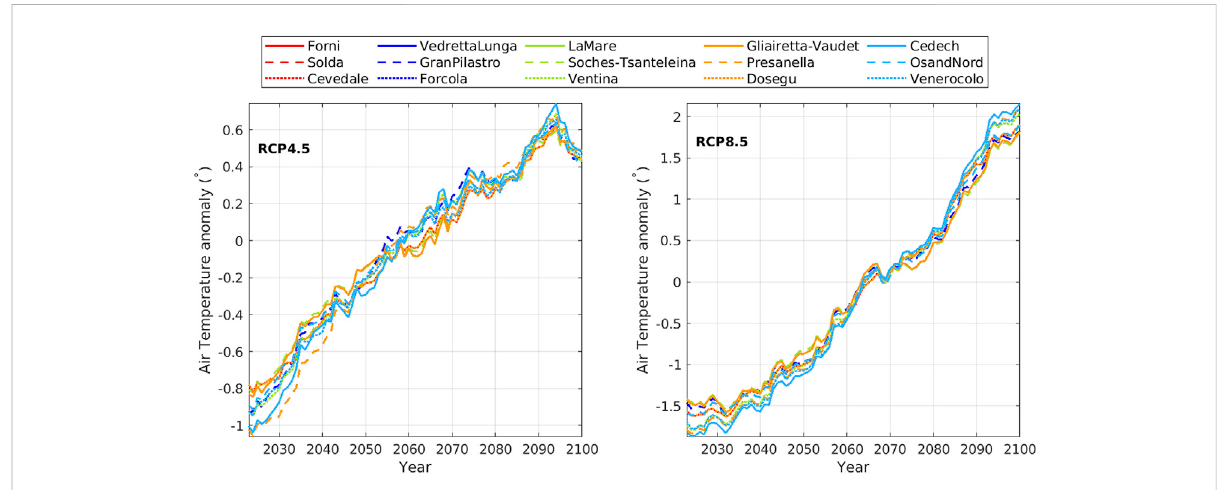
FIGURE 4 The ensemble air temperatures variations over the six regional models at the grid points closest the glaciers position from 2023 to 2100. Left panel: RCP4.5 scenario. Right panel: RCP8.5 scenario. The colours are sorted from the longest (red) to the shortest (light blue) glacier; due to the proximity of some glaciers, some curves